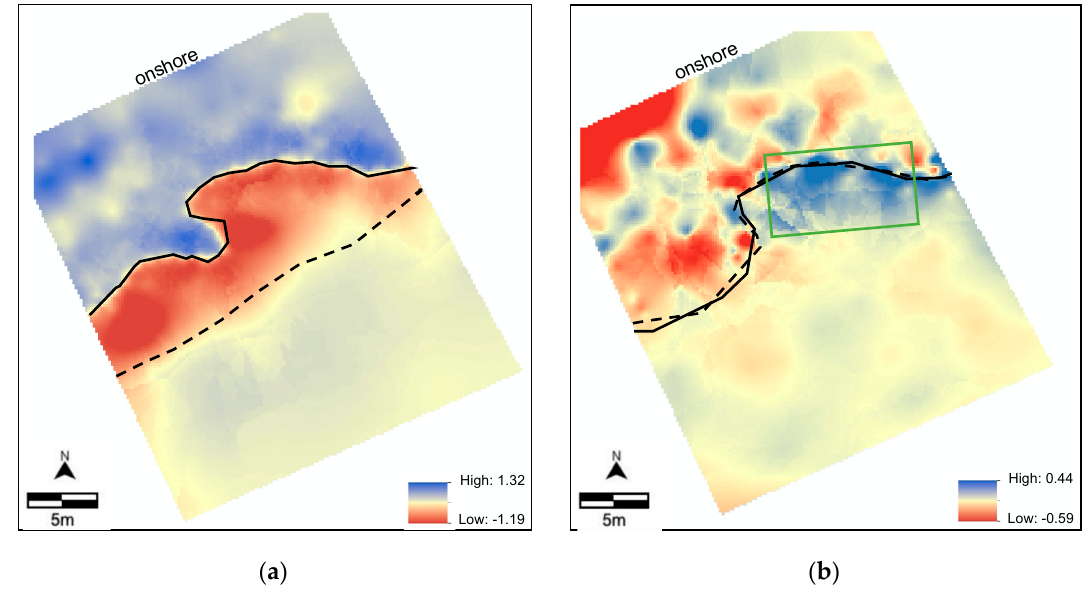
Figure 6. Site A digital elevation models (DEM) change maps for Hurricanes ( a ) Irma and ( b ) Florence . The dashed and solid lines show the pre- and post-storm dune toe lines, respectively. Table 2. Dune volumes (m 3 and normalized volumes ( nv )) for pre- and post- Irma and Florence for Sites A and B. Irma Florence